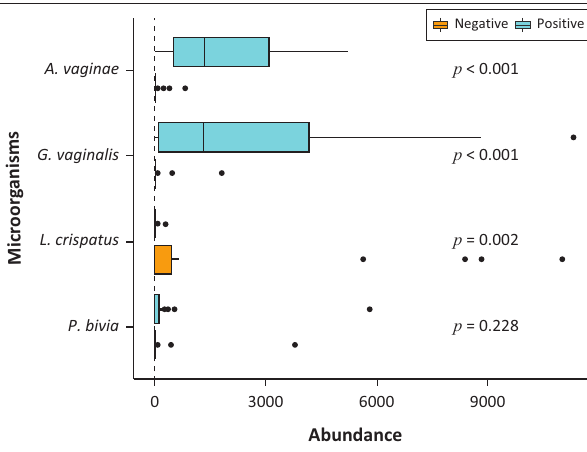
FIGURE 2: The abundance of each microorganism in relation to bacterial vaginosis status. Gactobacillus vaginalis was shown to be the most abundant microorganism in bacterial vaginosis-positive samples . Lactobacillus crispatus was the most dominant microorganism in bacterial vaginosis- negative samples.